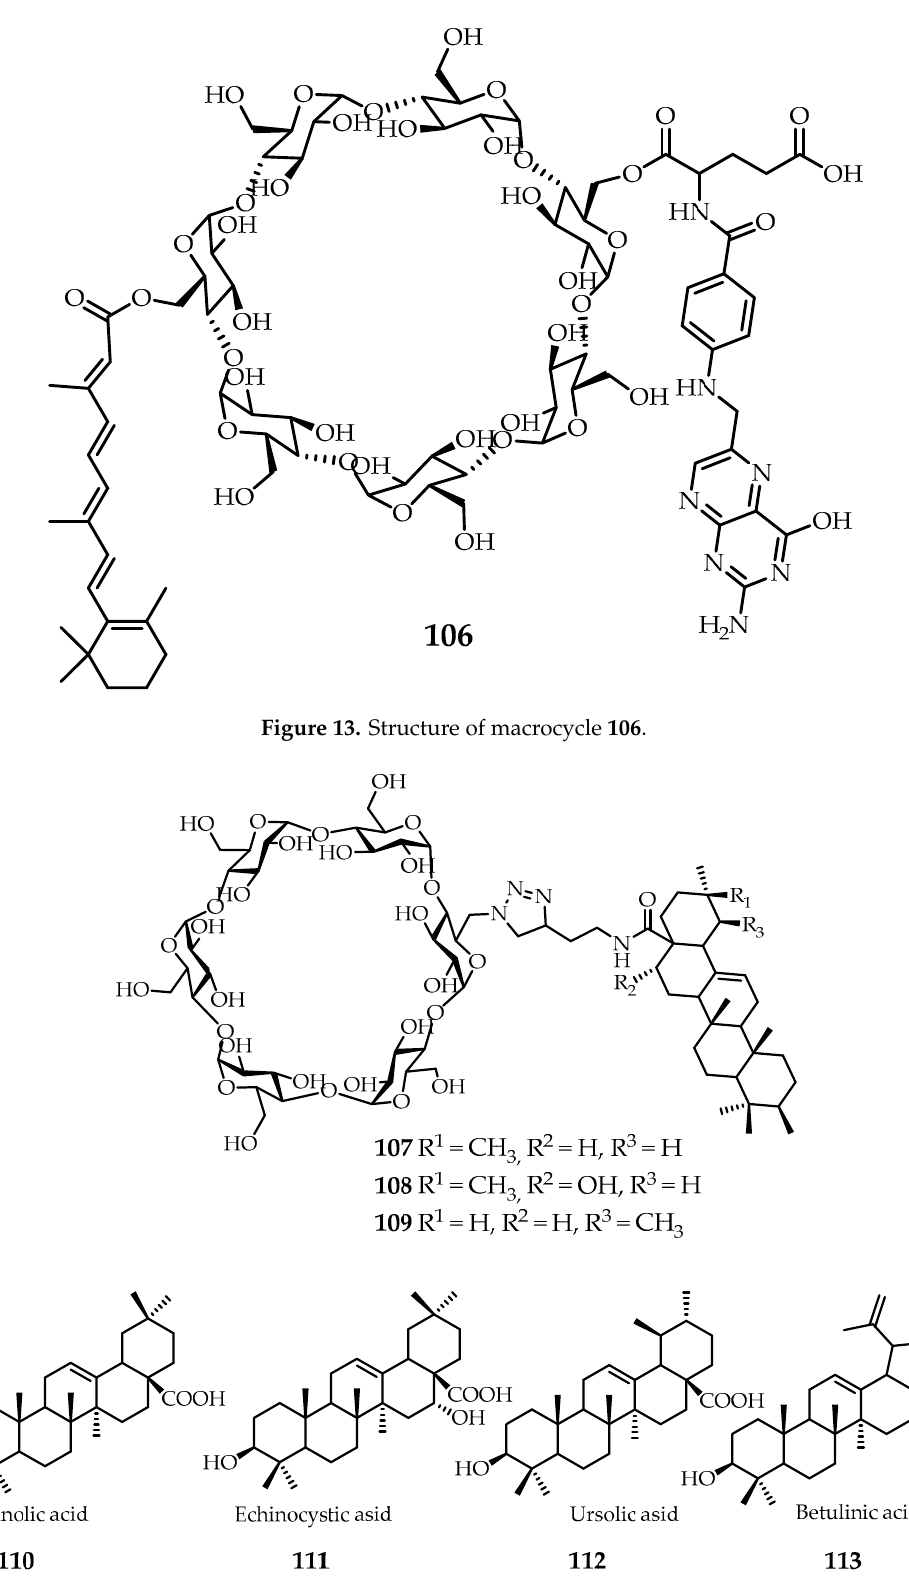
Figure 14. Structures of compounds 107-113 .